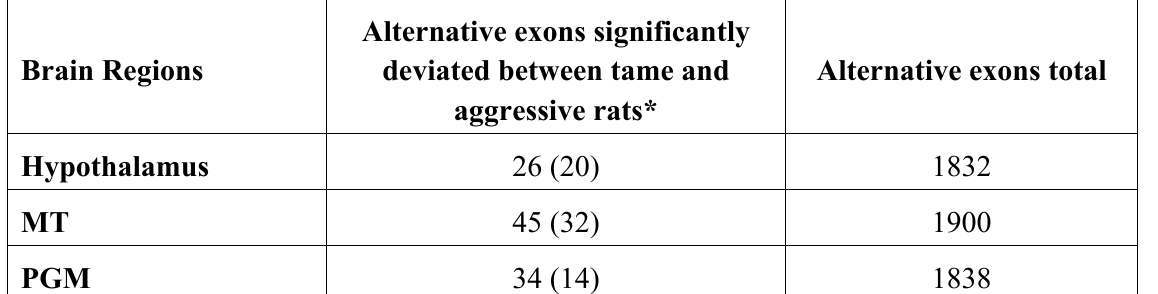
Table 1: Distribution of significant (FDR<0.05) differential exon splicing events across 3 tissues in rat brain.